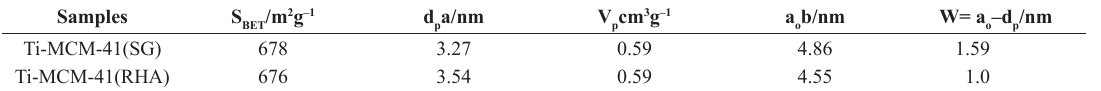
Table 3. Adsorption parameters for theTi-MCM-41 (SG) and Ti-MCM-41(RHA). Samples